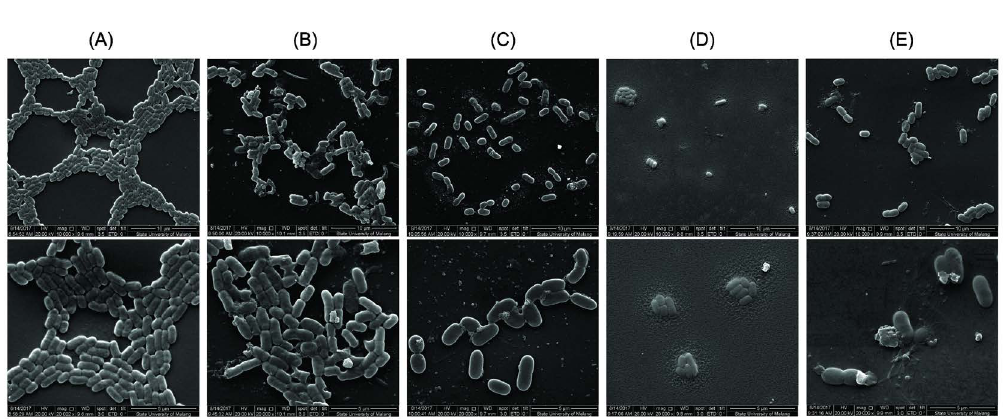
Fig. 1. Structure of K. pneumoniae biofilms observed by scanning electron microscopy (SEM): K. pneumoniae (A), K. pneumoniae exposed with : kefir supernatant (B), kefir pellet (C), grain kefir supernatant (D) and grain kefir pellet (E). Magnification: 10.000x (first row) and 20.000x (second row)